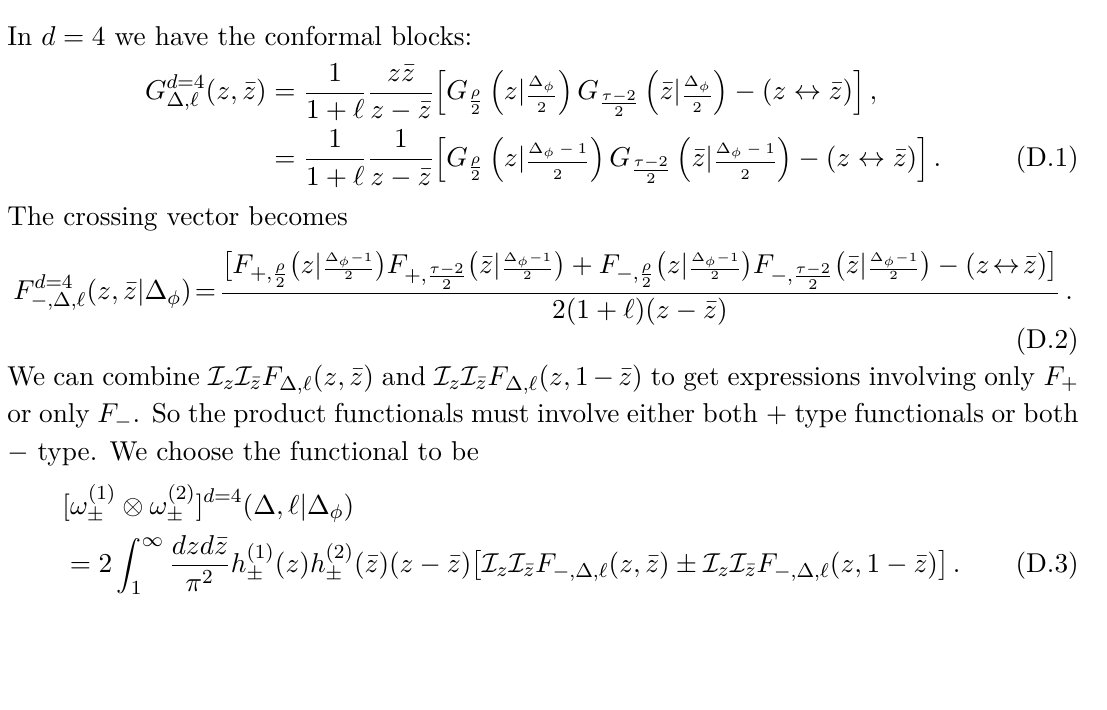
+ p become prominent on adding 8